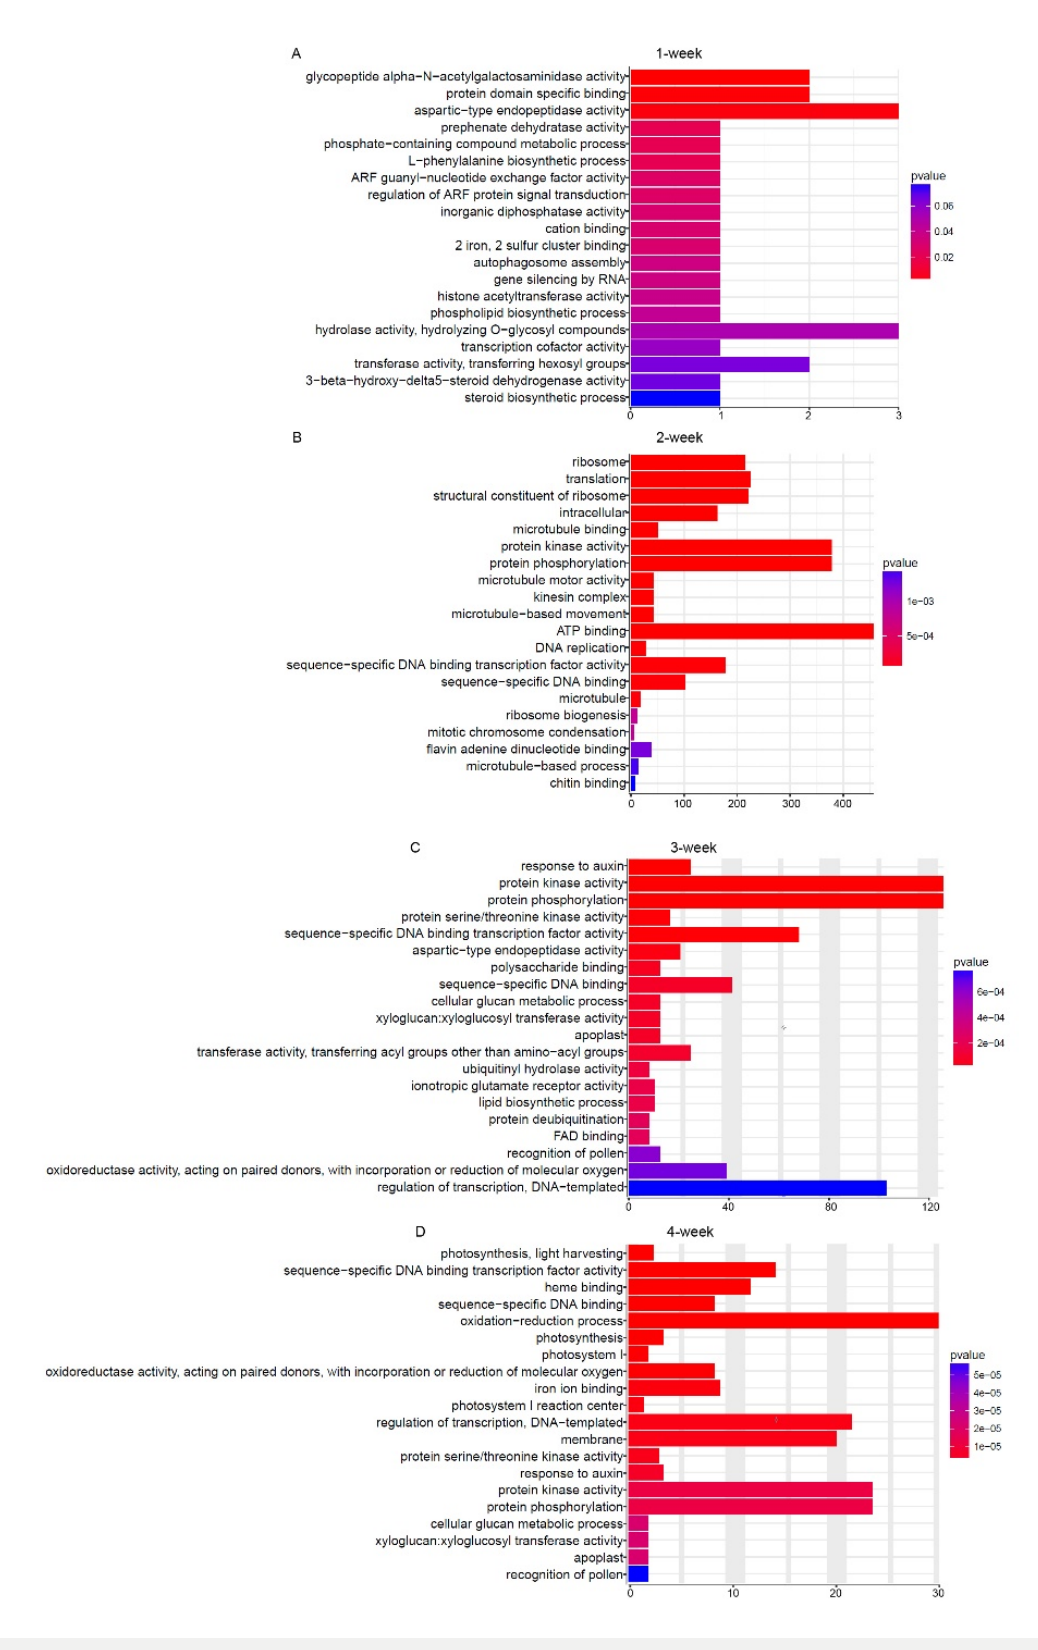
Figure 6 FHY3/FAR1 regulates genes with diverse functions. Enrichment of selected categories of GO biological processes in genes differentially expressed in fhy3 far1 compared to the wild-type genome in 1 ( A ), 2 ( B ), 3 ( C ), and 4 ( D ) week. Functional annotation of those differentially expressed genes into the biological process, cellular component, and molecular function categories within the GO